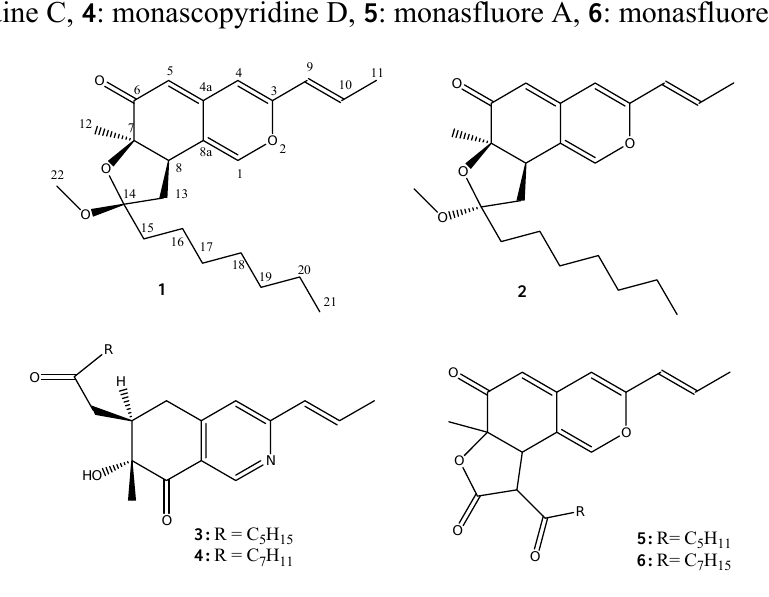
Figure 1. The structures of compounds 1 - 6 ( 1 : monapurfluore A:, 2 :, monapurfluore B 3 : monascopyridine C, 4 : monascopyridine D, 5 : monasfluore A, 6 : monasfluore